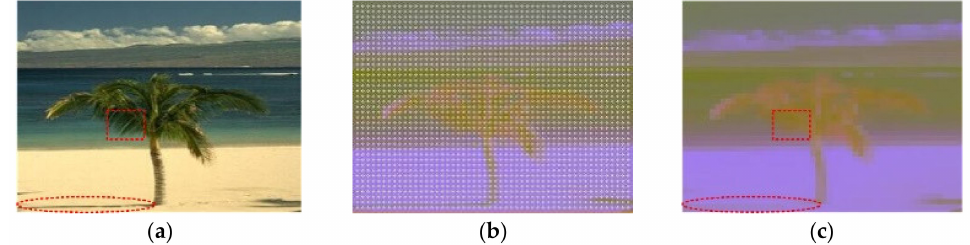
Figure 2. Image preprocessing. ( a ) Original image, ( b ) Lab image and the grid feature points, ( c ) the smoothed and filtered